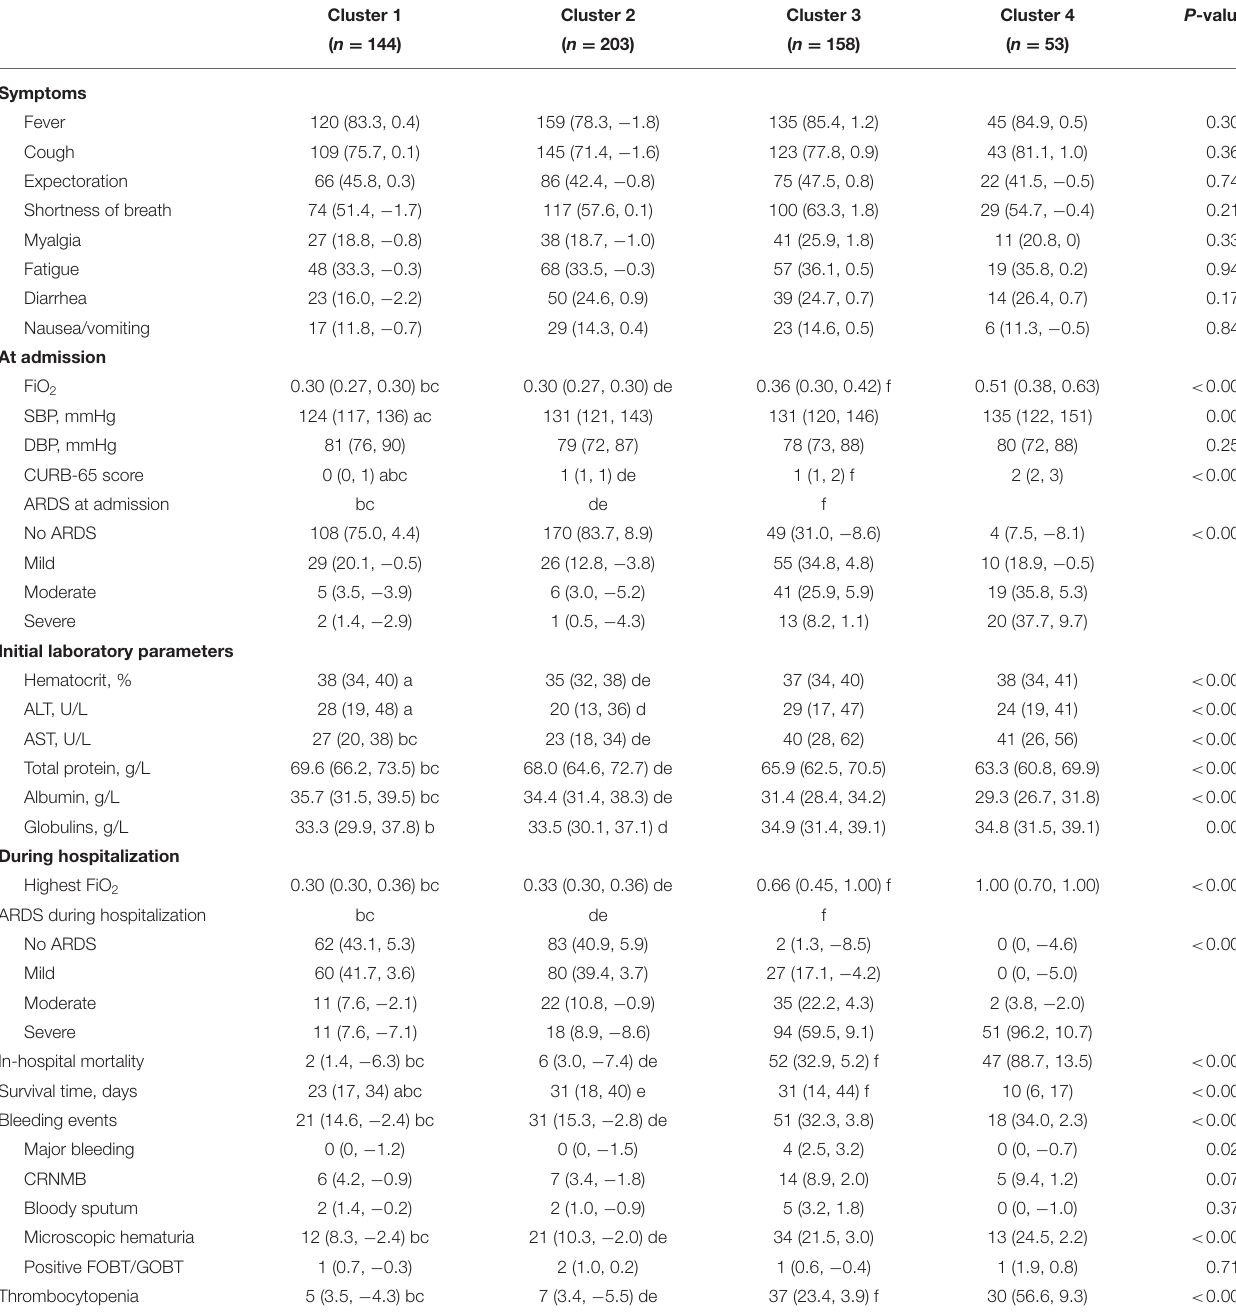
TABLE 5 | Outcome and variables not included in the PAM-based clustering